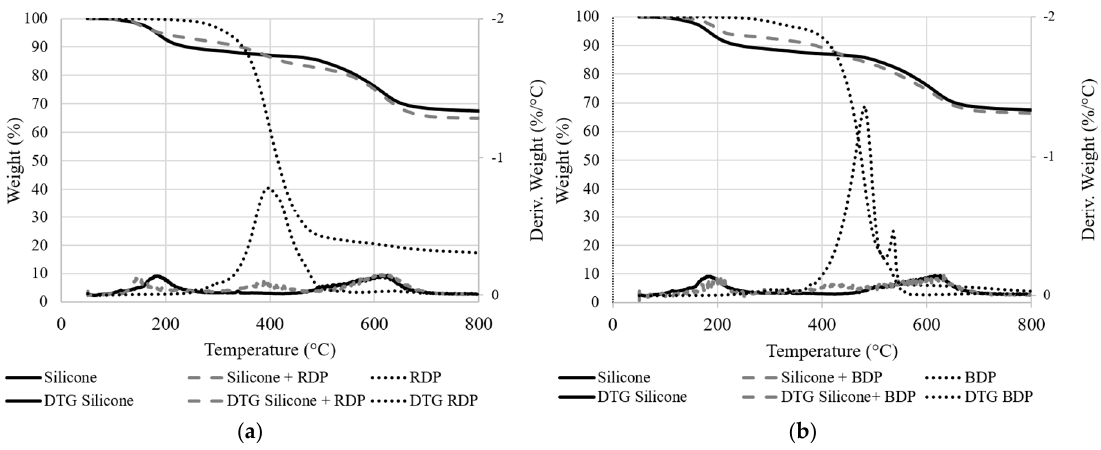
Figure 6. Comparison of TG and DTG curves of the silicone system with and without ( a ) RDP and ( b ) BDP (10 wt.%) under nitrogen at a heating rate of 20 °C/min.